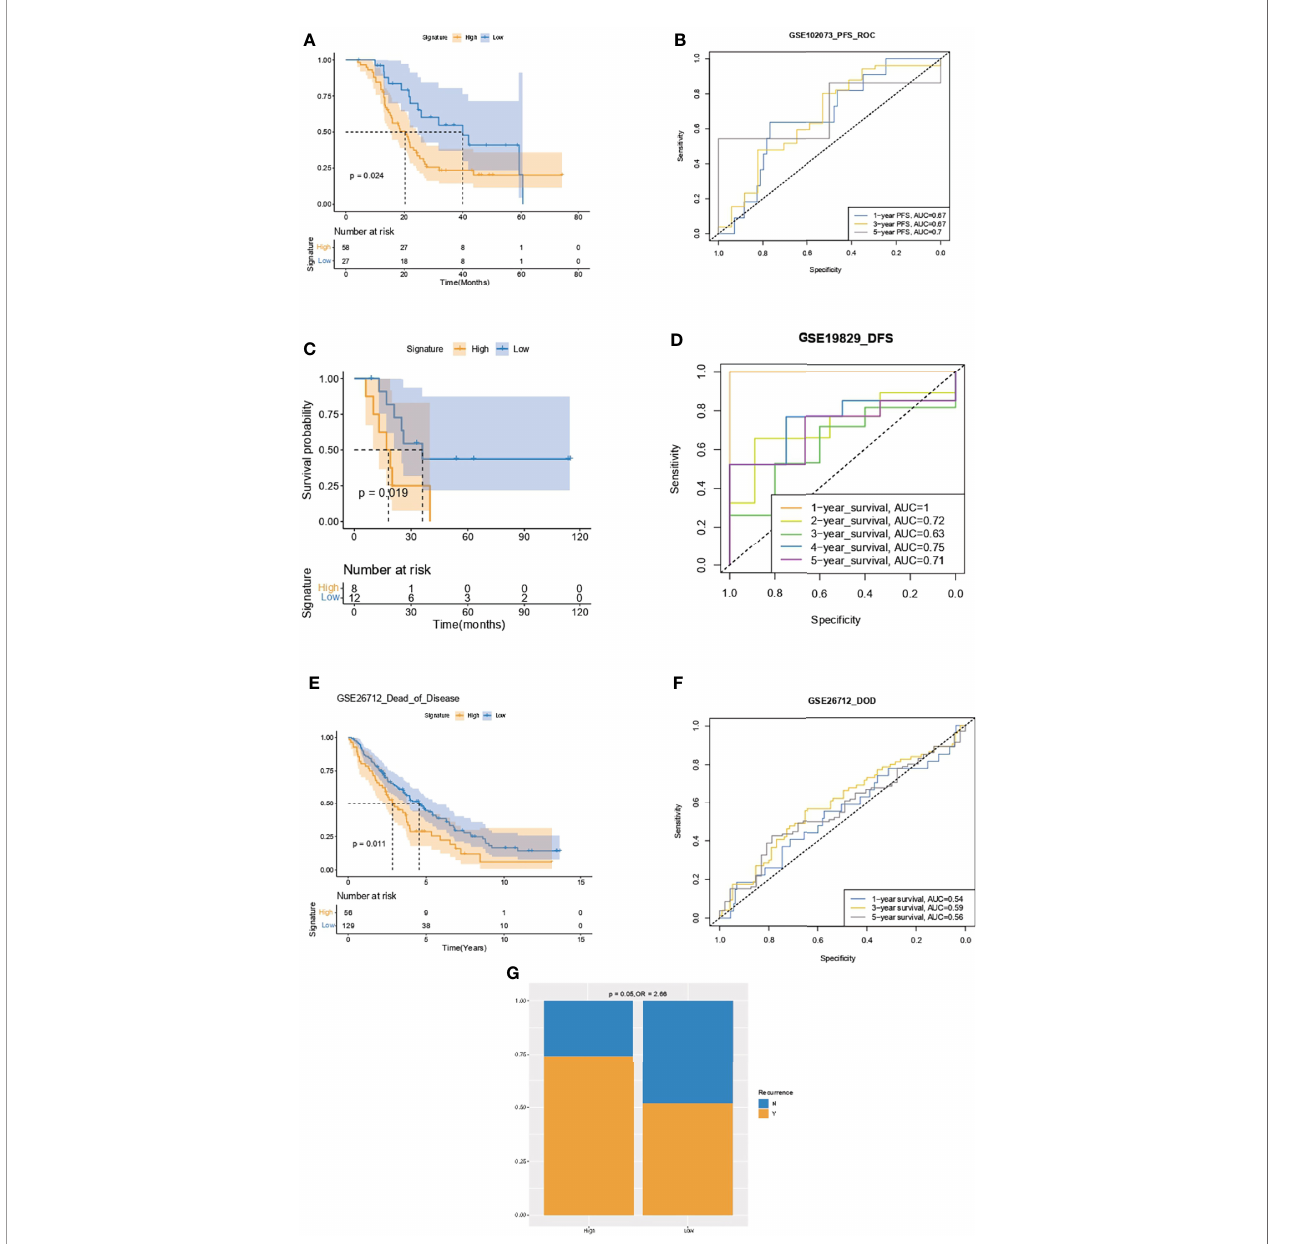
FIGURE 8 | Validation of the capacity of IPR signature in survival prediction. Kaplan – Meier analysis and ROC curve of the IPR signature in prediction the PFS in the GSE102073 (A, B) , DFS in GSE19829 (C, D) , and time to DOD in GSE26712 (E, F) . (G) The distribution of patients with disease recurrence in the high- or low-IPR signature. Ovarian cancer patients were divided into high- and low-IRP signature group according to the optimal cutoff value in each cohort. PFS, progression-free survival; DFS, disease-free survival; DOD, dead of